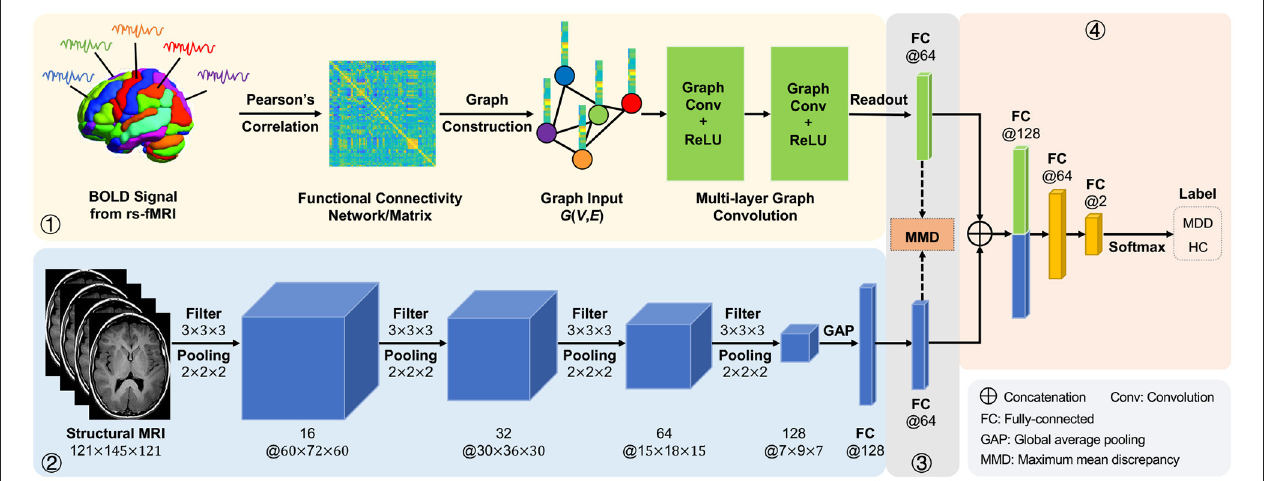
FIGURE 1 | Illustration of the proposed adaptive multimodal neuroimage integration (AMNI) framework, including (1) a graph convolutional network (GCN) for extracting features of functional connectivity networks derived from resting-state functional MRI (rs-fMRI) data, (2) a convolutional neural network (CNN) for extracting features of T1-weighted structural MRI (sMRI) data, (3) a feature adaptation module for alleviating inter-modality difference by minimizing a cross-modal maximum mean discrepancy (MMD) loss, and (4) a feature fusion module for integrating sMRI and fMRI features for classification. MDD, major depressive disorder; HC, healthy